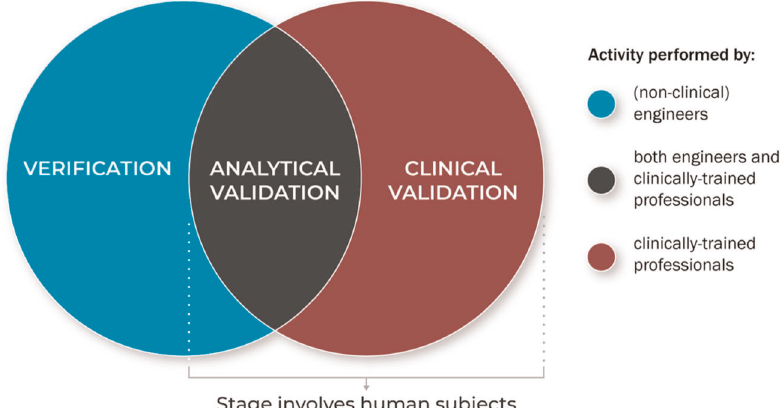
Fig. 4 The role of the different disciplinary experts in the V3 process: Veri fi cation, analytical validation, and clinical validation processes are typically conducted by experts across disciplines and domains. V3 processes are typically conducted by experts across disciplines and